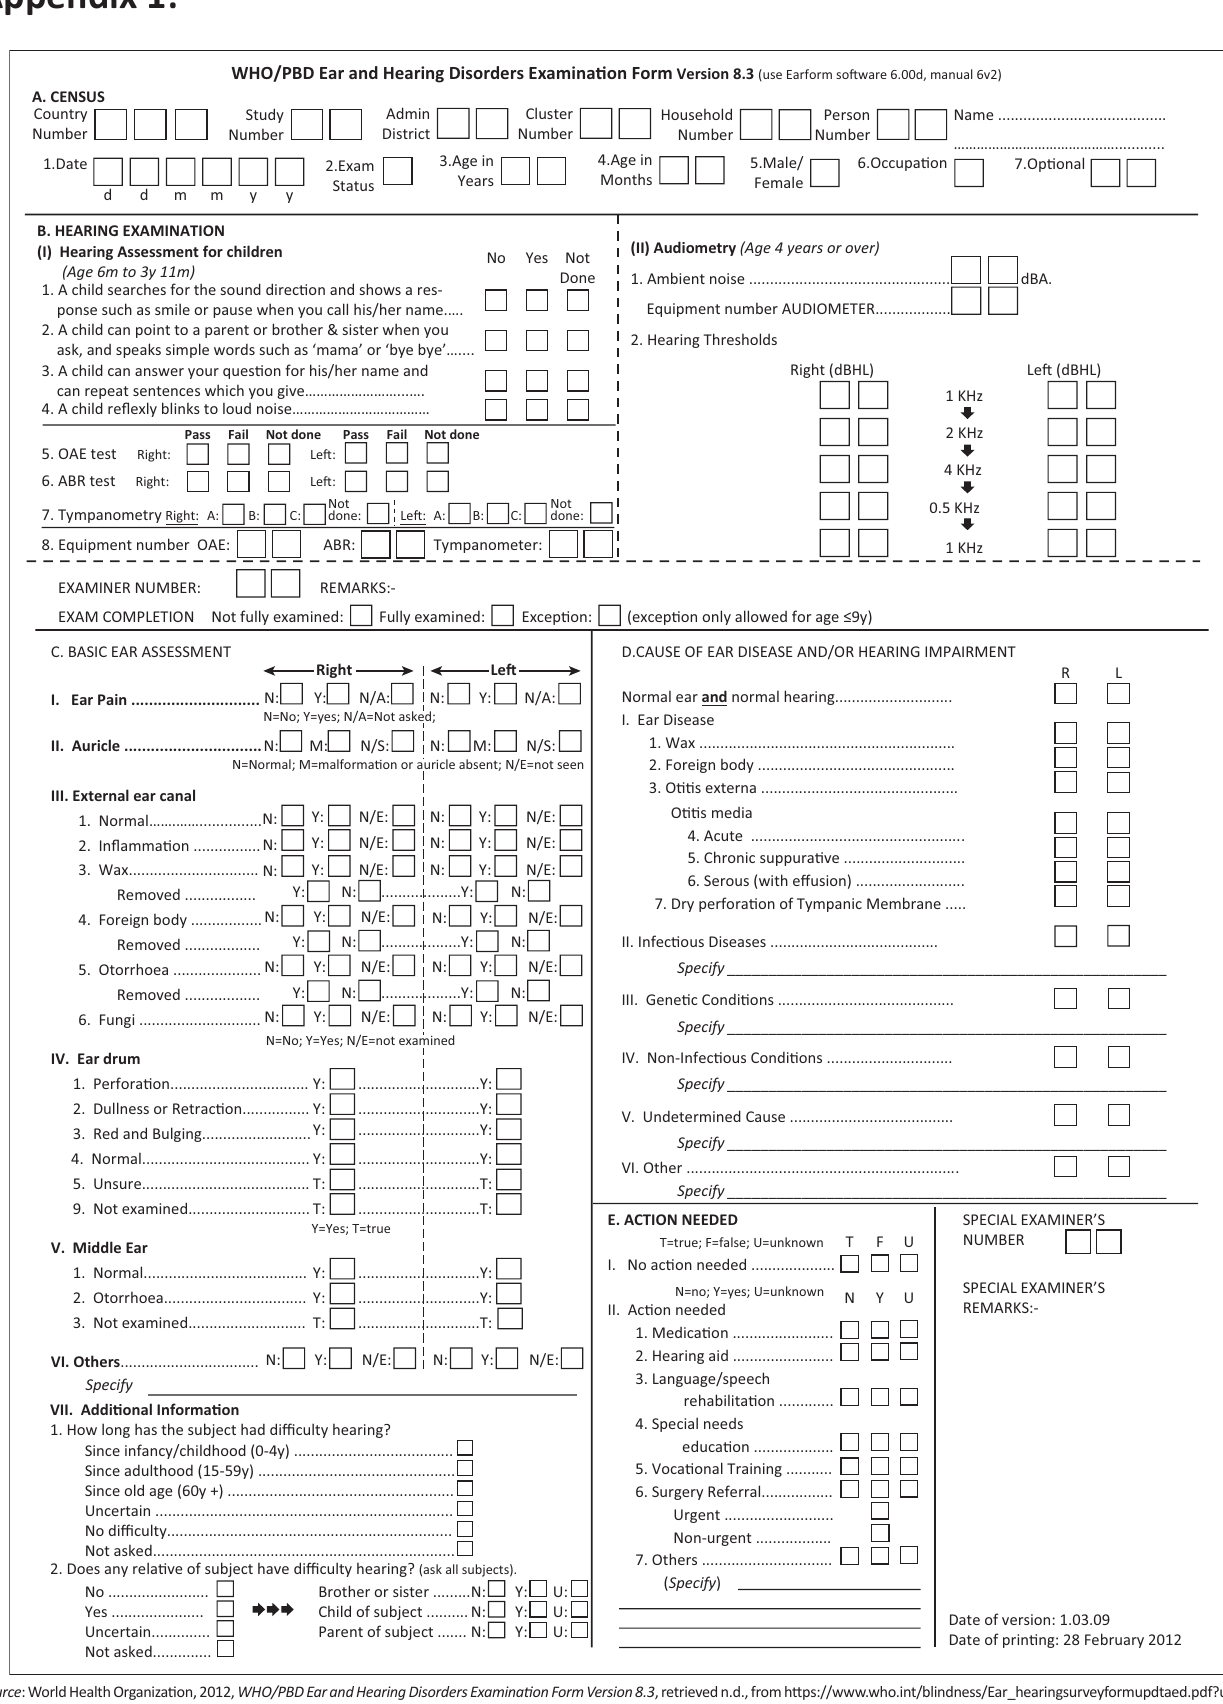
FIGURE 1-A1: World Health Organization Ear and Hearing Disorders Examination Form: Version